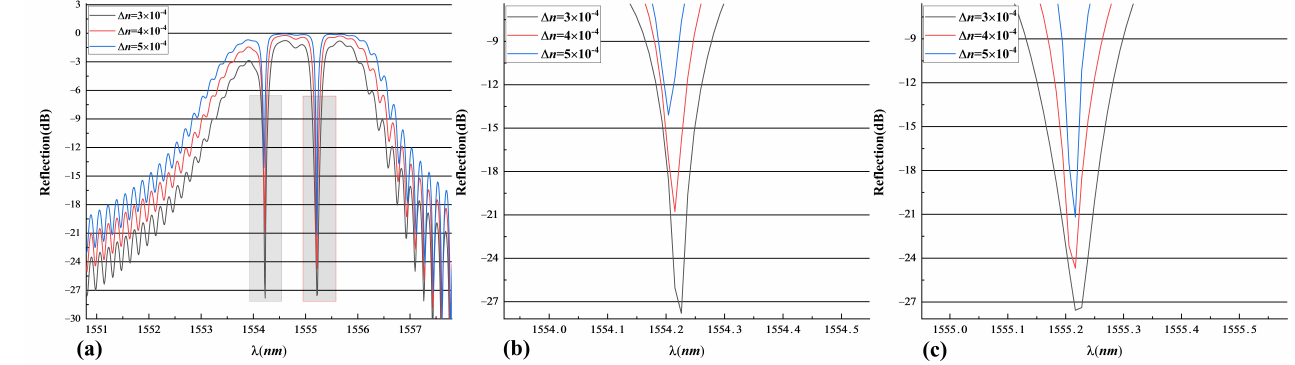
Figure 6. The effect of refractive index modulation on the spectral properties. ( a ) Spectrograms at different refractive index modulation depths; ( b , c ) show magnified views of the shaded regions in ( a